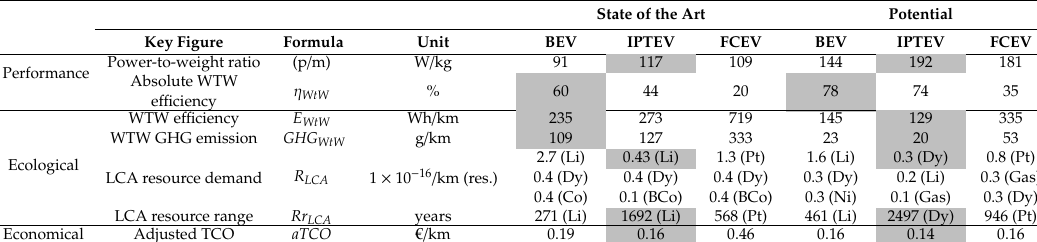
Table 4. KPIs of passenger car in